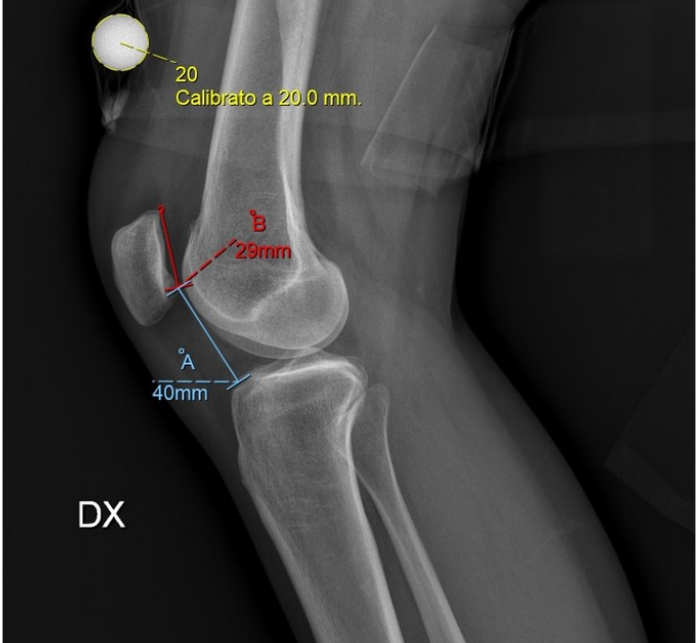
Figure 1. Caton–Deschamps index (CDI) assessed in a preoperative radiography of the knee, lateral view. In this example, CDI corresponds to 1.38, being 𝐴 𝐵(cid:3415) = 40 29(cid:3415) = 1.38 , which means patella alta. Knowing that CDI should not be more than 1.2, using the proportion B x 1.2, we obtained the value B ′ (29 × 1.2 = 34.8 mm) which corresponds to the maximum hypothetical length of A so that the patella does not result high. Then, with a simple subtraction, B − B ′ = 40 − 34.8 = 5.2 mm, we calculated the distance of which we want to lower the bony brat during surgery. A 20 mm calibration marker is essential for making the correct lowering calculations.